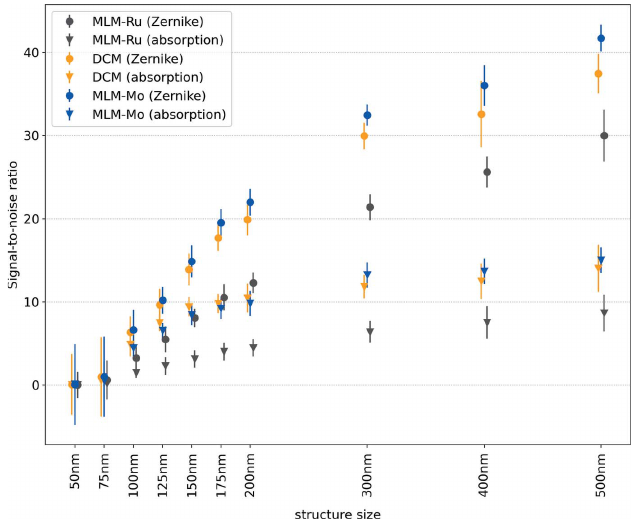
Figure 9 The signal-to-noise ratio for different structure sizes of the Siemens star for both absorption and Zernike phase